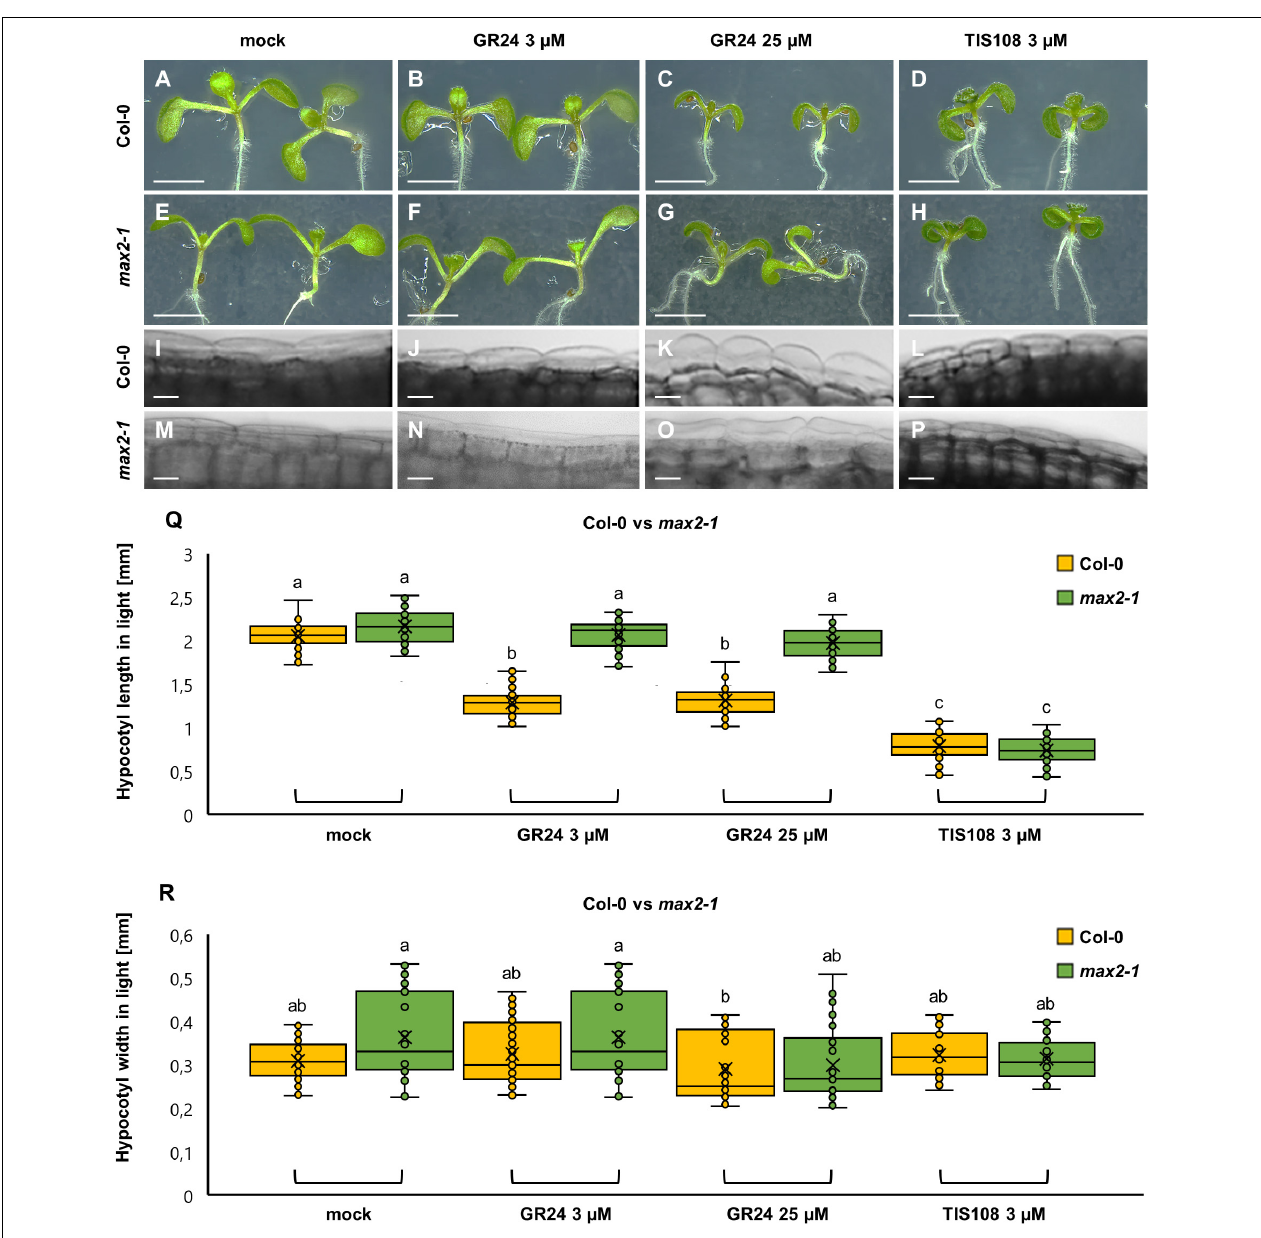
FIGURE 1 | Hypocotyl development of light-grown seedlings of Arabidopsis Col-0 or the max2-1 mutant in the presence or absence of the synthetic strigolactone GR24 (3 µ M and 25 µ M) or the biosynthetic inhibitor of strigolactone production TIS108 (3 µ M). (A–D) Overview of hypocotyl of Col-0 seedlings treated with solvent alone (mock) (A) , 3 µ M GR24 (B) , 25 µ M GR24 (C) , and 3 µ M TIS108 (D) . (E–H) Similar overview of hypocotyls of light-grown max2-1 mutant seedlings in mock (E) , 3 µ M GR24 (F) , 25 µ M GR24 (G) , and 3 µ M TIS108 (H) . (I–L) Magnified views of the middle part of hypocotyls of Col-0 treated with mock (I) , 3 µ M GR24 (J) , 25 µ M GR24 (K) , and 3 µ M TIS108 (L) showing cell swelling in all treatments (J–L) compared to mock (I) . (M–P) A similar comparison was made of max2-1 hypocotyl epidermal cells treated with mock (M) , 3 µ M GR24 (N) , 25 µ M GR24 (O) , and 3 µ M TIS108 (P) . (Q) Quantitative assessment of Col-0 and max2-1 hypocotyl length comparing pairwise mock treatment and treatments with 3 µ M GR24, 25 µ M GR24, and 3 µ M TIS108 ( N ≥ 59; two-way ANOVA was followed with Scheffé’s test; a statistical comparison is shown within groups sharing the same genotype; letters in the graph are shared by groups without statistically significant differences at the 0.001 probability level; results are in Supplementary Table 1 ). (R) Quantitative assessment of Col-0 and max2-1 hypocotyl width comparing pairwise mock treatment and treatments with 3 µ M GR24, 25 µ M GR24, and 3 µ M TIS108 ( N ≥ 27; two-way ANOVA was followed with Scheffé’s test; a statistical comparison is shown within the groups sharing the same genotype; letters in the graph are shared by groups without statistically significant differences at the 0.001 probability level; results are in Supplementary Table 2 ). In all box plots, the average is presented by × , median by the middle line, 1 st quartile by the bottom line, 3 rd quartile by the top line; the whiskers lie within the 1.5 × interquartile range (defined from the 1 st to the 3 rd quartiles), while outliers are omitted. Scale bars: 5 mm (A–H) ; 5 µ m (I–P)